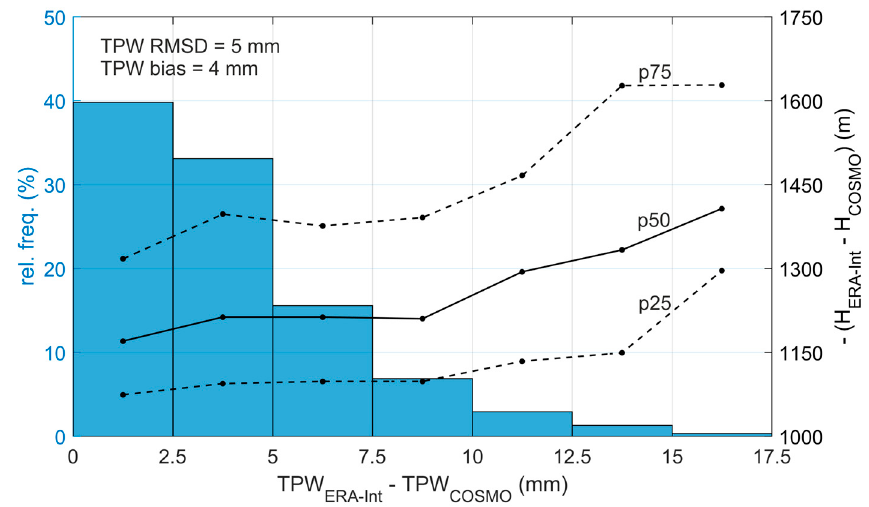
Figure 5. Histogram representing the relative frequency of ERA-Int TPW departures from COSMO reference TPW (in blue) for classes of 0.25 cm over the Alps for 2014. Median, 25th, and 75th percentiles of differences of height between ERA-Int and COSMO are shown in black lines.